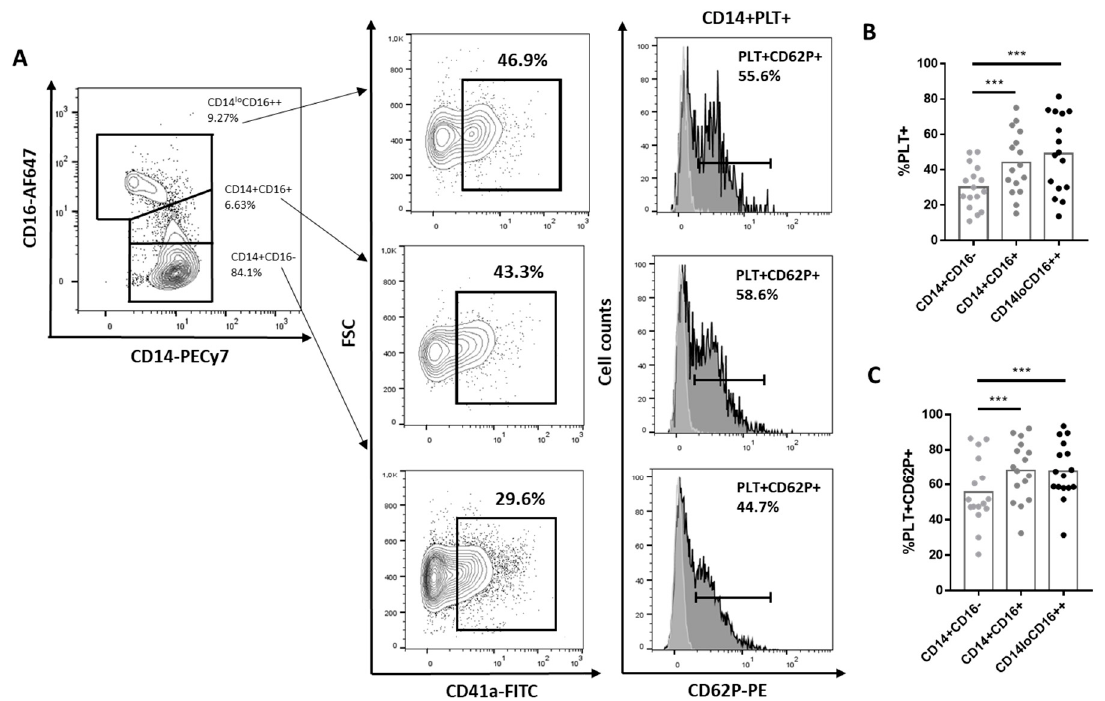
Figure 1. Percentage of CD14+CD16-, CD14+CD16+ and CD14+CD16++ with bound platelets. ( A ) A representative experiment showing the gating strategy for identifying monocyte subsets CD14+CD16-, CD14+CD16+ and CD14+ CD16++. CD14+ with bound PLTs (CD14+CD41a+) and monocytes with activated bound platelets (CD14+CD41a+CD62P+) (dark histograms). Light grey histograms represent CD62P expression on each subpopulation of monocytes without PLTs. ( B ). Percentage of CD14+PLT+ in each monocyte subset from 16 independent experiments ( C ). Percentage of monocytes with activated bound platelets (PLT+CD62P+) in each CD14+PLT+ monocyte subset from 16 independent experiments. Statistical analysis was performed using one-way ANOVA with Tukey’s multiple comparisons test. *** p < 0.001.